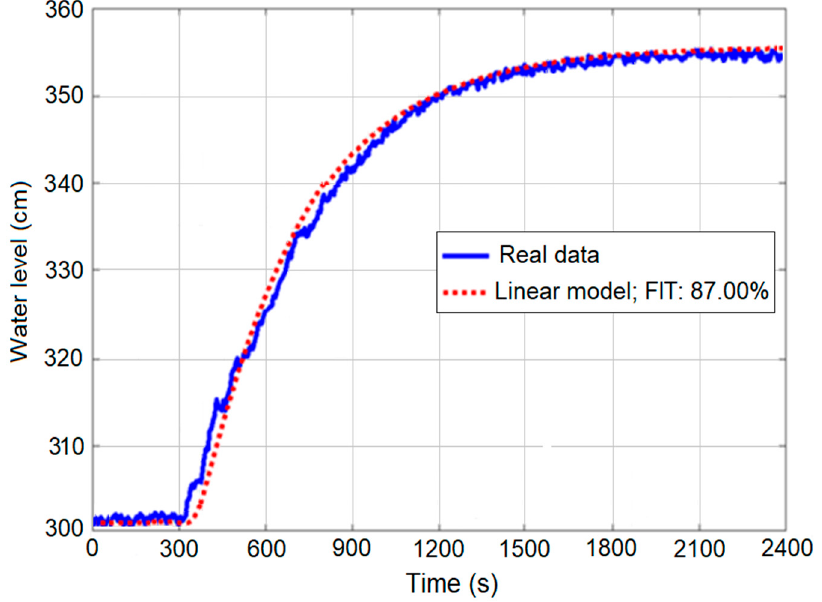
Figure 7. Validation results of the obtained linear mathematical model.